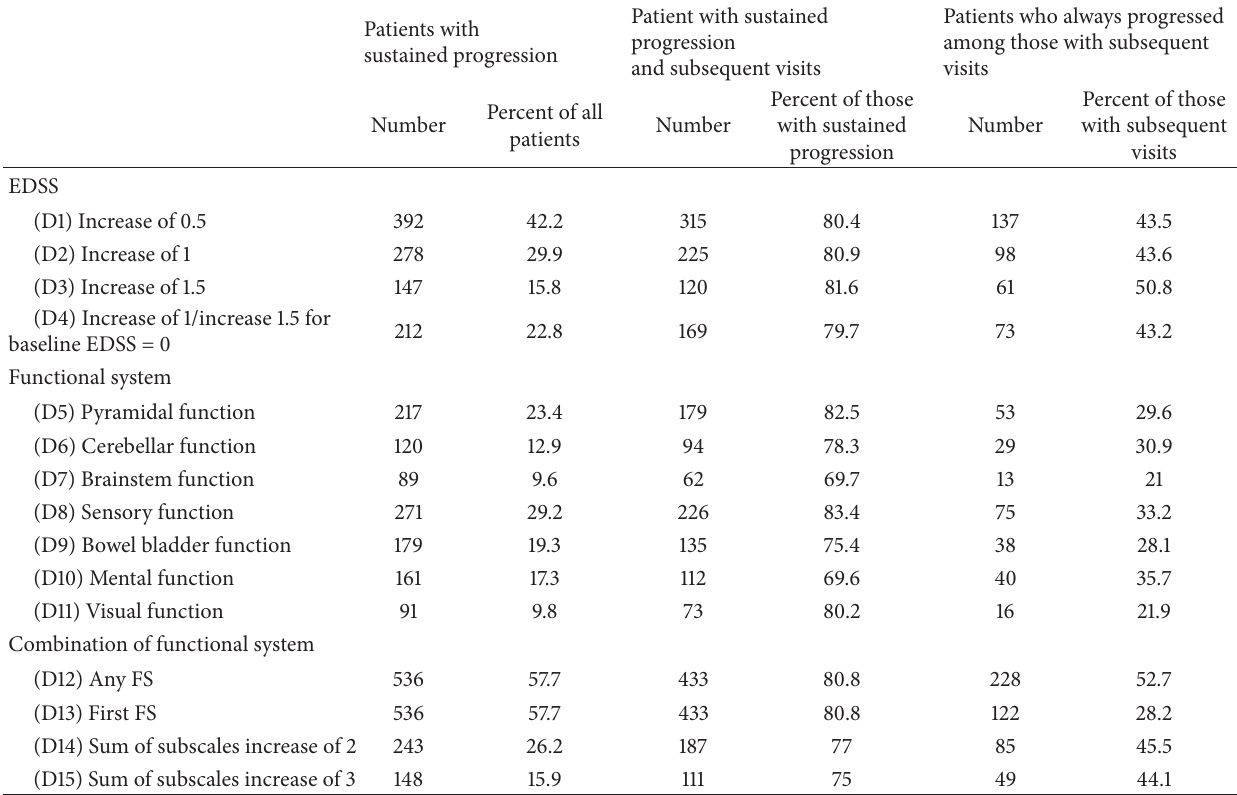
Table 2: Patients who met each definition of sustained progression during followup.